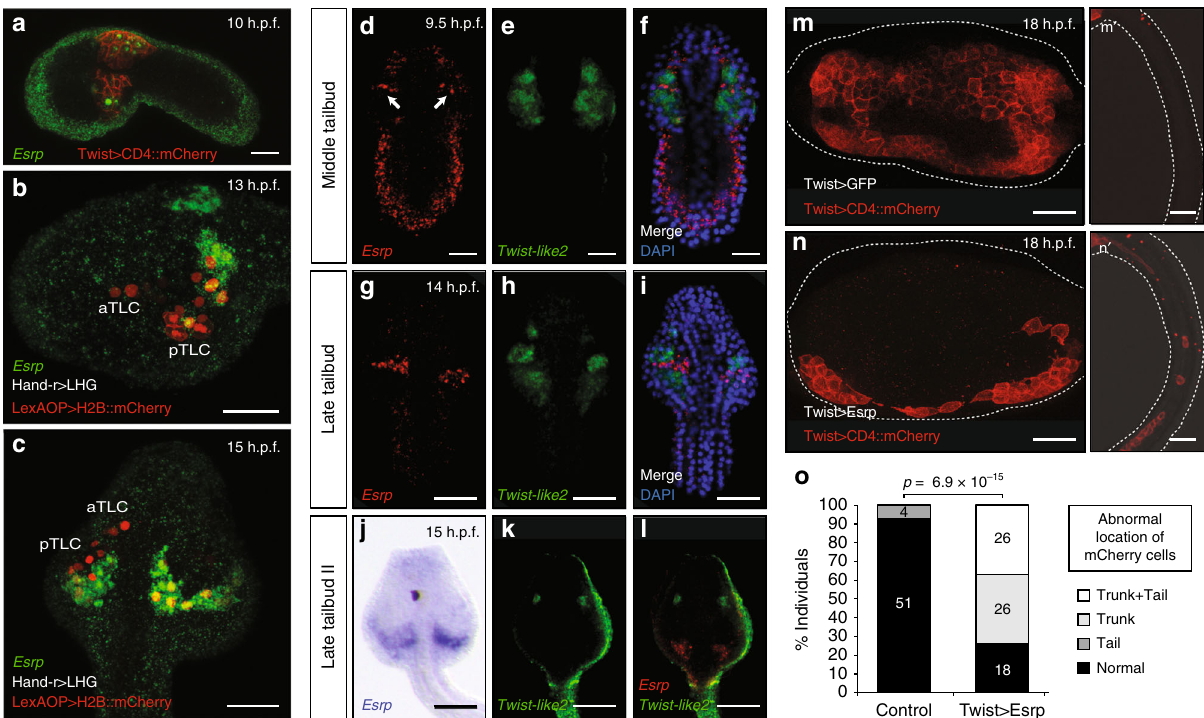
Fig. 2 Esrp is expressed in a subpopulation of TLCs in Ciona and is able to modulate cell motility in the mesenchymal lineage. a Esrp expression (green) is detected at 10 h.p.f. by fl uorescent WMISH in the epidermis and in some cells within the mesenchymal lineage, as shown by co-staining with mChe driven by the Twist promoter, which labels the Twist-like1 -derived cell lineage. b , c Esrp (green) is expressed in the TLC lineage as shown by co-staining with Hand- r > LHG/LexAOP > H2B::mCherry (red) in 13 h.p.f. and 15 h.p.f. embryos in lateral b and dorso-lateral c views, respectively. aTLC: Anterior TLCs, pTLC: posterior TLCs. d – l Double fl uorescent WMISH for Esrp (red) and Twist-like2 (green), with the exception of j , which corresponds to colorimetric Esrp mRNA staining (purple). At middle tailbud stage, Esrp expression is detected in both epidermis and mesenchymal cell lineage (the latter is marked by arrows). m - m ’ Mesenchymal lineage in WT larvae at 18 h.p.f. stained in red using the Twist > CD4::mCherry construct. Twist > GFP was used as co-electroporation control plasmid, showing full co-electroporation (green channel not shown for clarity). n – n ’ Mesenchymal lineage stained in larvae co-electroporated with Twist > CD4::mCherry and Twist > Esrp constructs. The trunk region is shown in m – n , while tail segments are shown in m ’ – n ’ . o Quanti fi cation of the different phenotypes of mesenchymal cell lineage motility observed in Twist > Esrp and control larvae. These included individuals with abnormal migration in the trunk ( ‘ Trunk ’ ), with ectopic mChe-positive cells in the tail ( ‘ Tail ’ ) or both phenotypes ( ‘ Trunk + Tail ’ ). P -values correspond to a two-sided Fisher Exact tests ( ‘ Normal ’ vs rest). Scale bars correspond to 25 µ